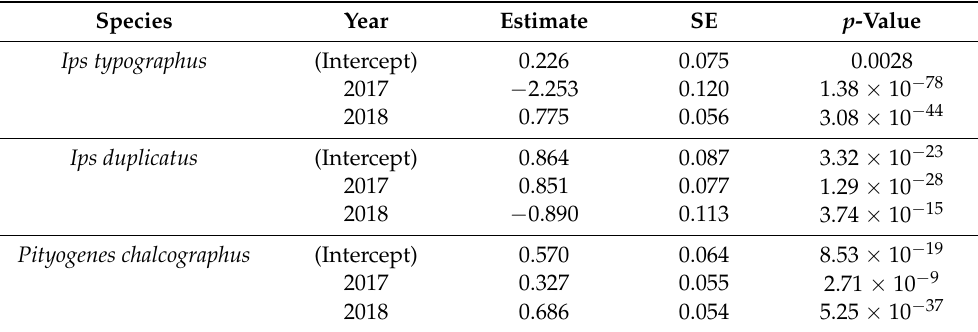
Table A1. Relationships between number of nuptial chambers and year, type of plot (distance from lure tree), and tree height of position of strip on trap tree as indicated by the general linear model log (number of nuptial chambers) = 1 + year + type + height. The coefficient estimates are accompanied with the standard error of estimate (SE) and the p -values.